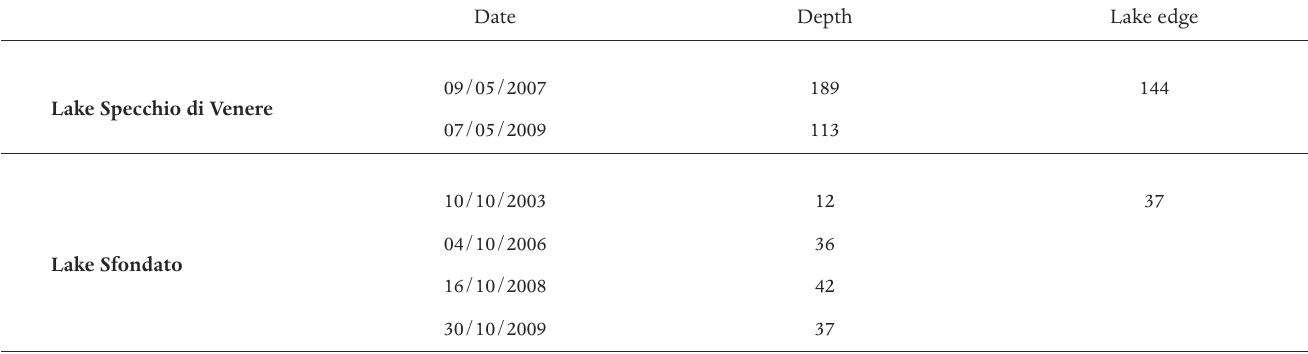
Table 1. List of the bathymetric surveys carried out on lakes Specchio di Venere and Sfondato with the total number of measurements for the determi- nation of water depths and positioning of the lake edges.